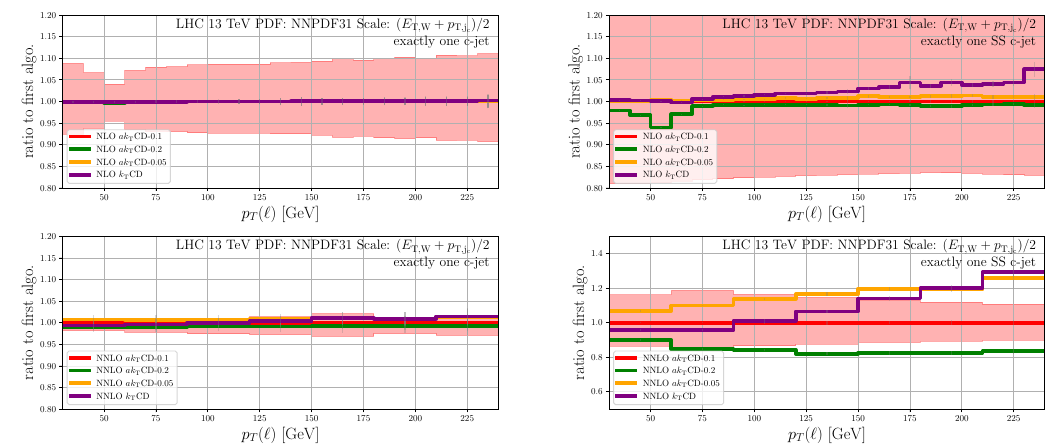
Figure 8 . Ratio of differential distributions in the rapidity of the charged lepton for the process √ pp → W + j at s = 13 TeV. The upper plots show the results at NLO QCD while the lower ones c are for NNLO QCD. The left-hand side plots are for one and only c-jet while the right-hand side ones are for one and only one c-jet of same-sign type. Various definition of the flavored anti- k algorithm are compared. In addition, these predictions are compared to the nominal flavored k algorithm (see